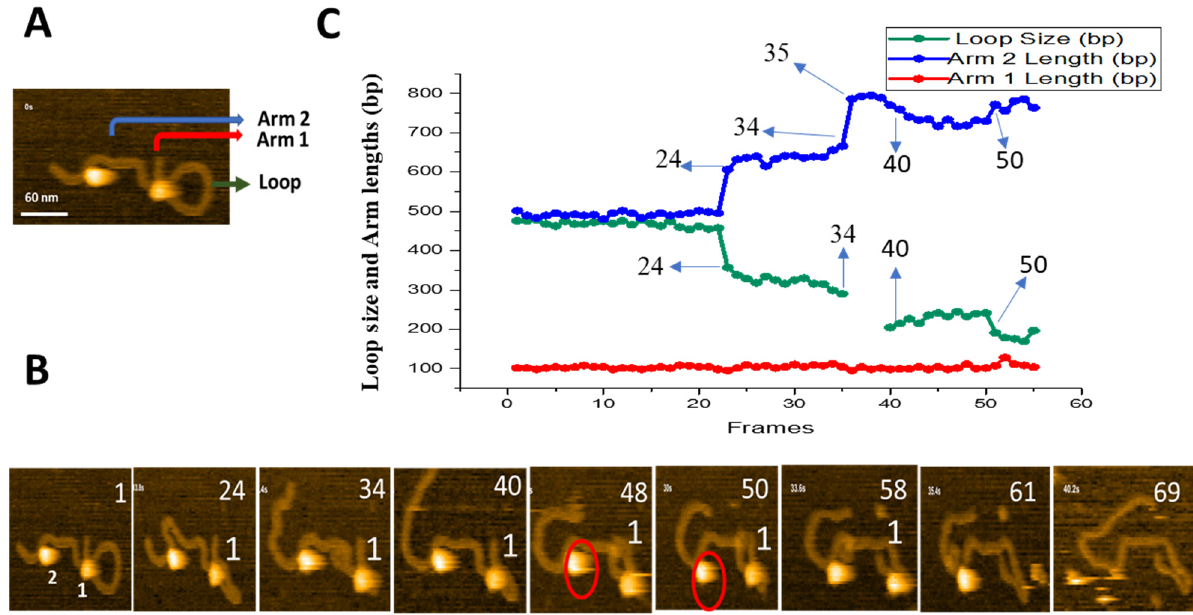
Figure 4. Threading pathway of SfiI site-search leading to loop size decrease. ( A ) Initial frame of movie S3. SfiI tetramer is seen as a bright feature at the center of the loop structure. The loop struc- ture is indicated with a green arrow, the small arm of the DNA (Arm 1) is labeled with a red arrow, and the long DNA arm (Arm 2) is labeled with a blue arrow. ( B ) Frames with key events. Frames 1 shows the presence of two SfiI tetramers labeled as 1 and 2. ( C ) Change in DNA contour lengths in bp over time. The green line shows the change in loop size, the red line depicts the change in Arm 1 length, and the blue line shows the changes in Arm 2 length. Other pathways have been observed, and the results are described in sections below.